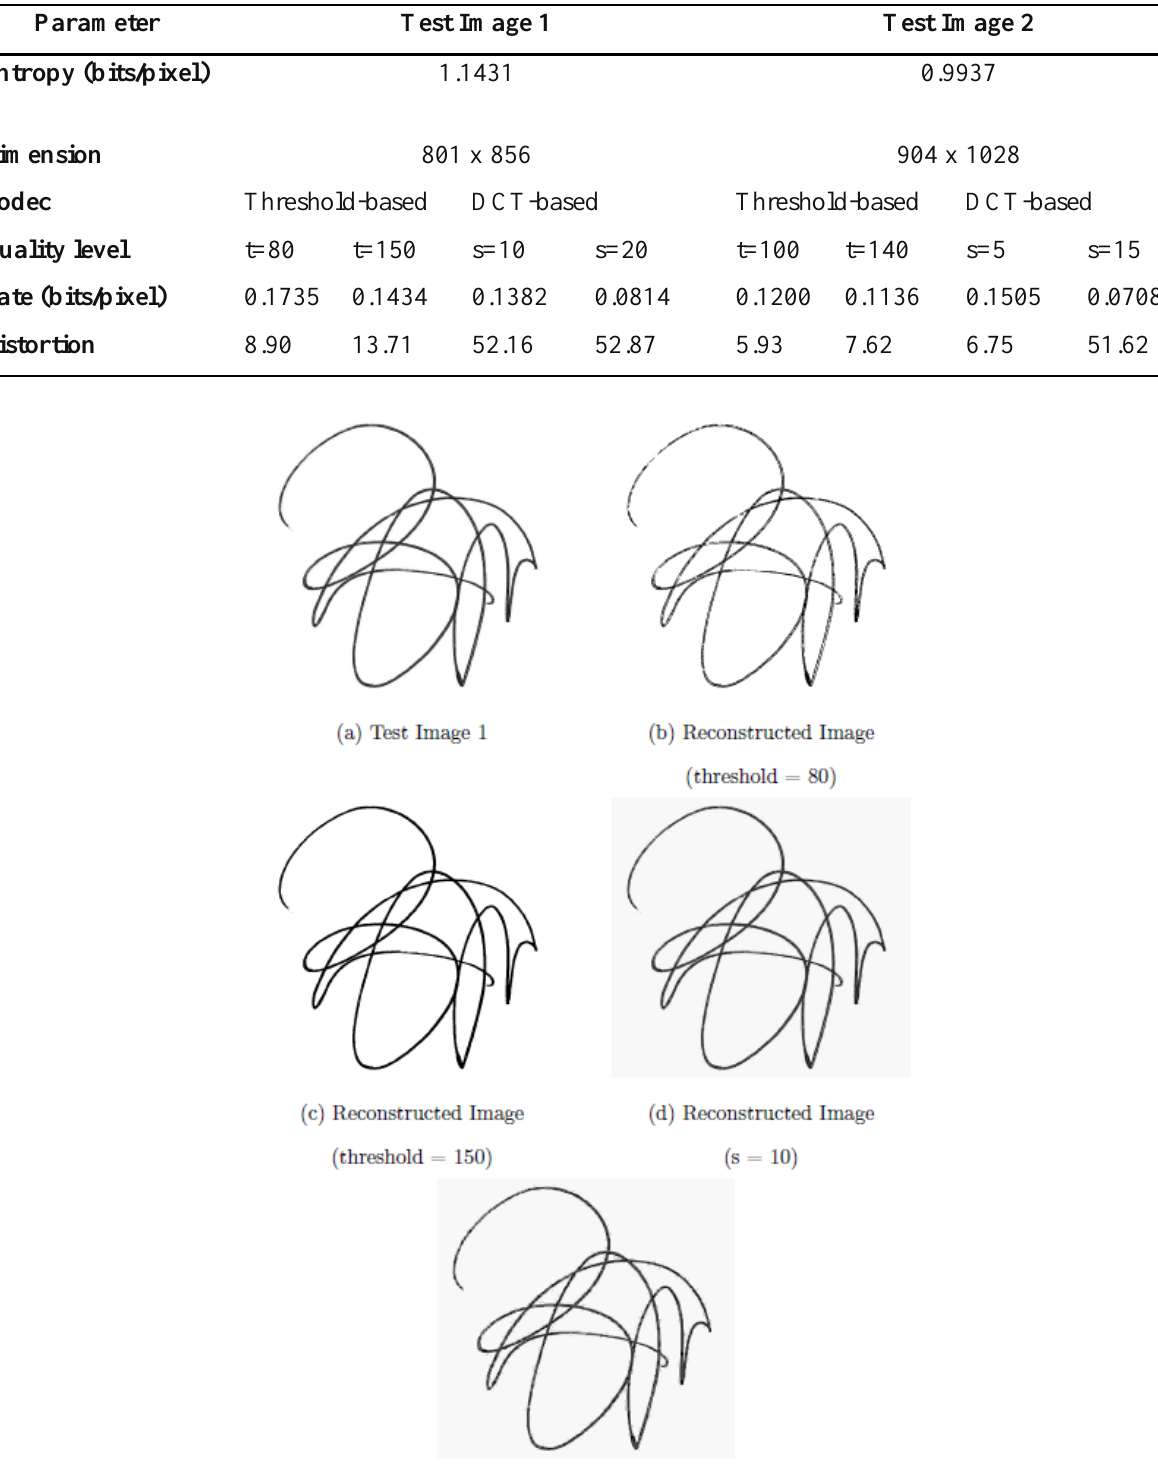
Table 1. Performance of both codecs with test images